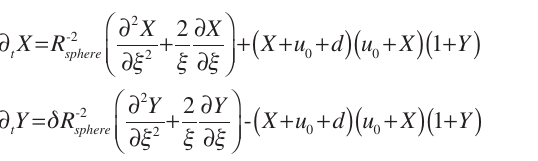
at 1 = 4.5 × 10 8 M -4 s -1 . b = 0.038 sup